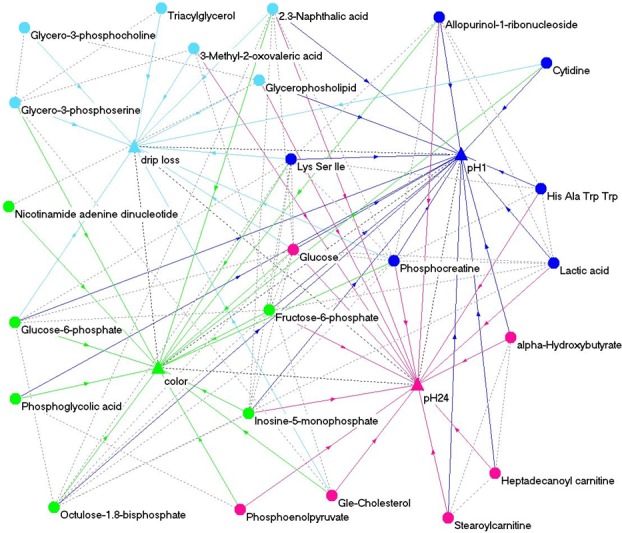
Metabolomic network of traits drip loss, pH1, pH24 and color and 24 strongly associated metabolites.dotted lines: undirected connections between metabolites and between traits; arrows: directed relations between metabolites and traits; triangles—traits; ellipses–metabolites; light blue–drip loss; blue–pH1; magenta–pH24; green–meat color; drip loss measured in Musculus longissimus dorsi (LD) 24 h post-mortem (p.m.); pH1 measured in LD 45 minutes p.m.; pH24 measured in LD 24 h p.m.; color = meat color measured in LD 24 h p.m.